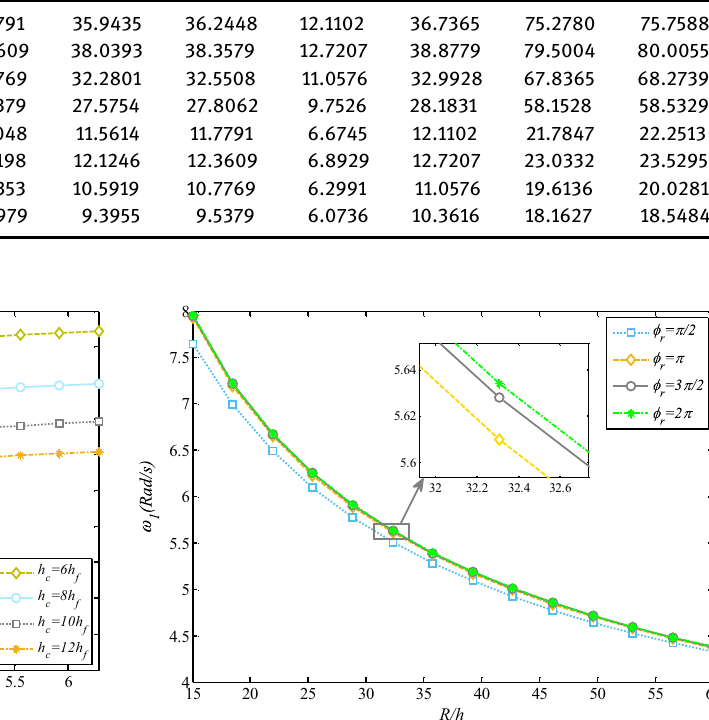
Figure 10: In fl uence of mid - radius to thickness and rotation angle on the shell ’ s natural frequencies ( h = 0.01 m , h c = 10 h f , L = 20 h , and μ = 1 ) U